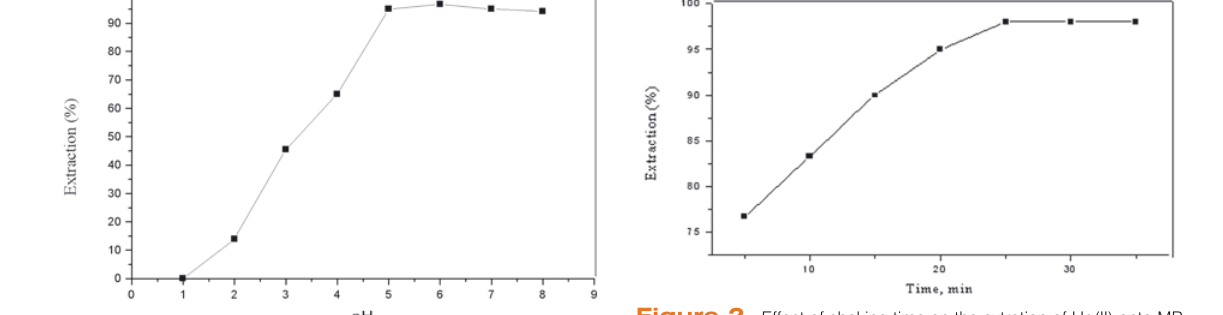
Figure 2. Effect of shaking time on the extration of Hg(II) onto MR- PUF average of three